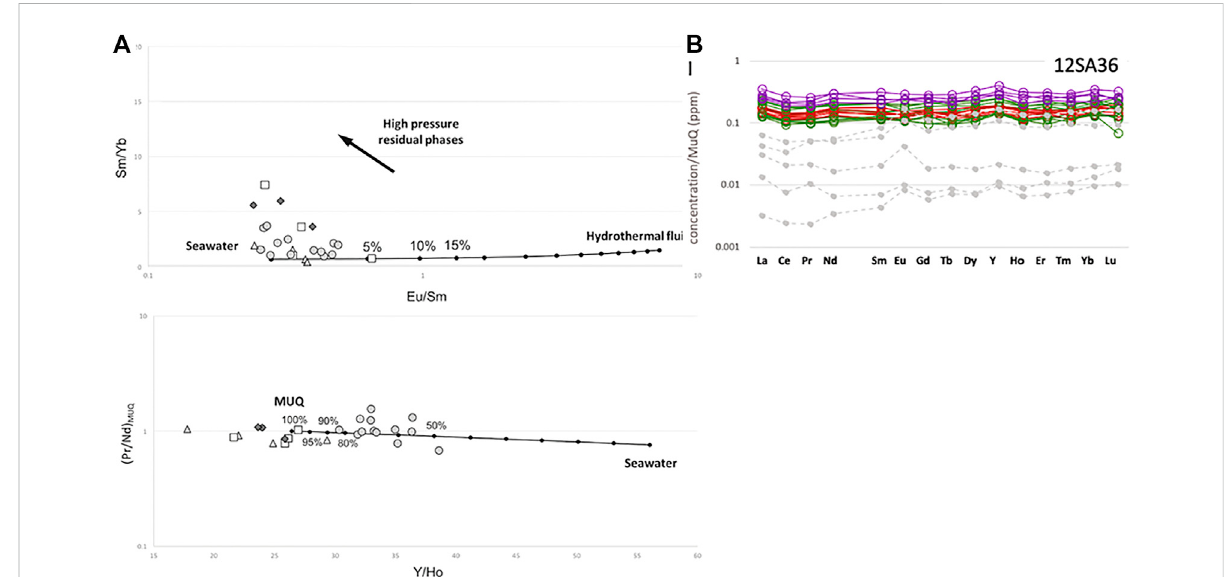
FIGURE 6 Geochemical evidence for seawater, hydrothermal and riverine signatures in the Palaeoarchaean shallow seas (the Josefsdal Chert, Barberton greenstone Belt). (A) The Sm/Yb and Eu/Sm ratios show a distinct hydrothermal in fl uence, while the Pr/Nd and Y/Ho ratios document a distinct terrigenous in fl uence (B) While bulk measurements of the Josefsdal cherts show the La, Eu and Y anomalies typical of hydrothermal fl uids, in situ measurements document the fl at REE distribution indicative of terrigenous, i.e., riverine input (After Hickman-Lewis et al.,